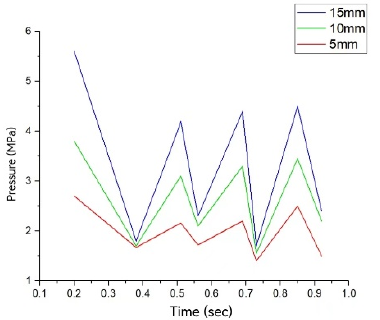
Figure 15. Maximum stress at the different raised cups.